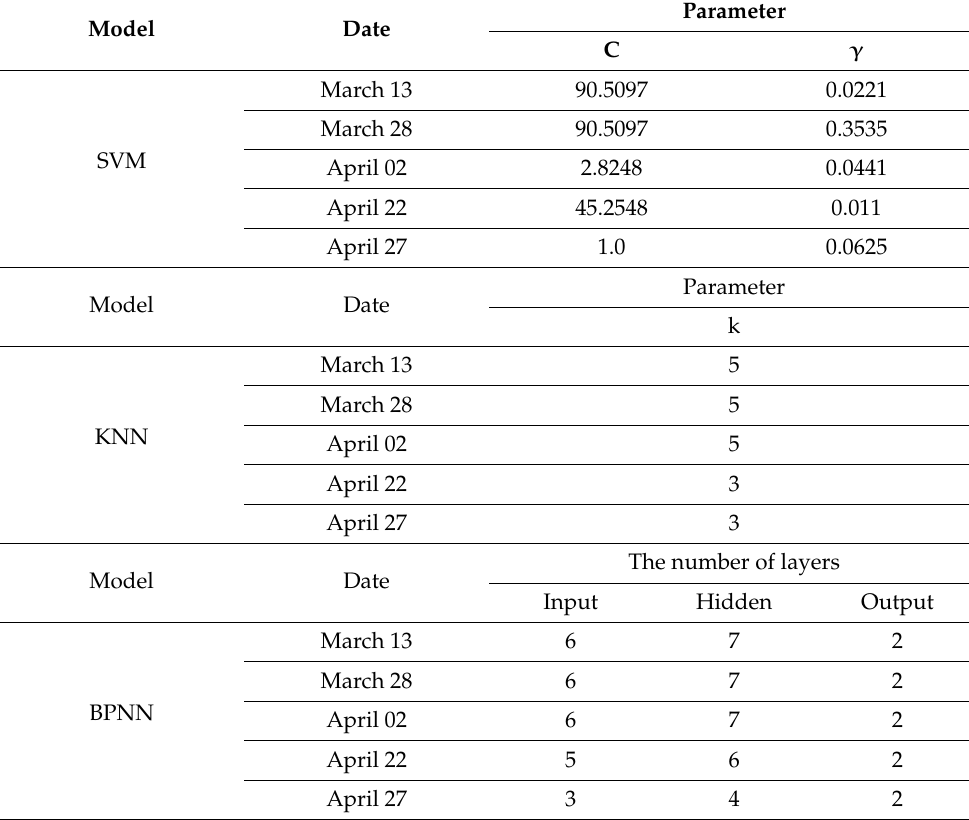
Table 6. The model parameters of the support vector machine (SVM), k-nearest neighbor (KNN), and back propagation neural network (BPNN) on (a) March 13; (b) March 28; (c) April 02; (d) April 22; and (e) April